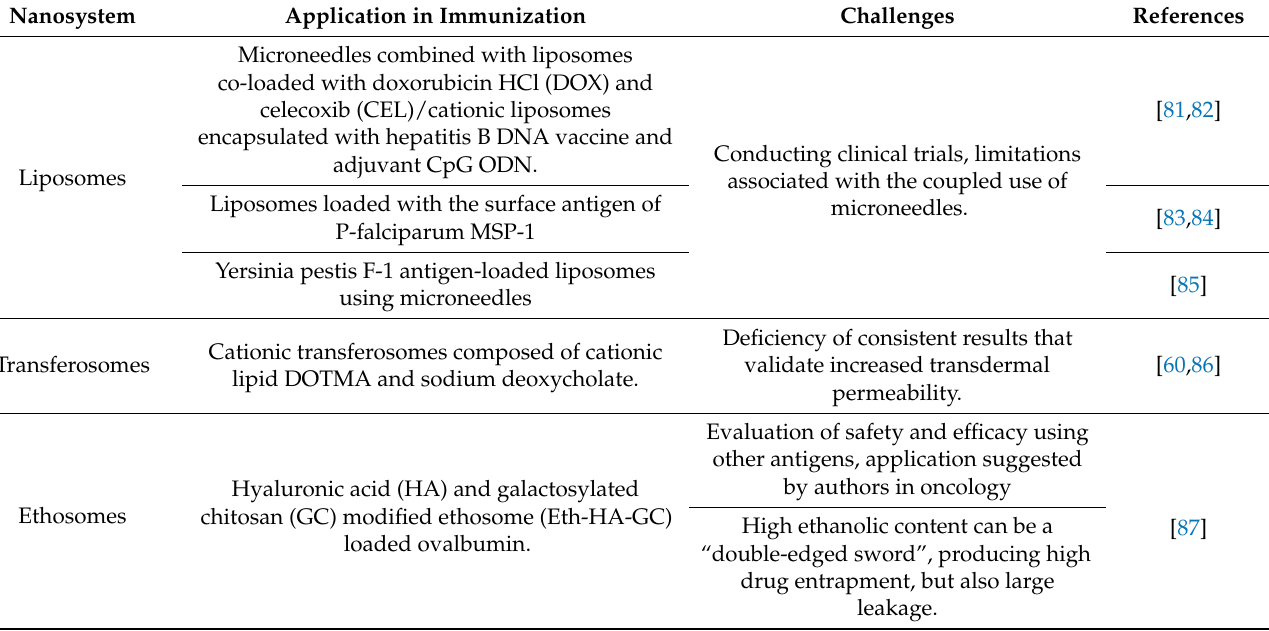
Table 2. Main Nanocarriers used in transdermal immunization.